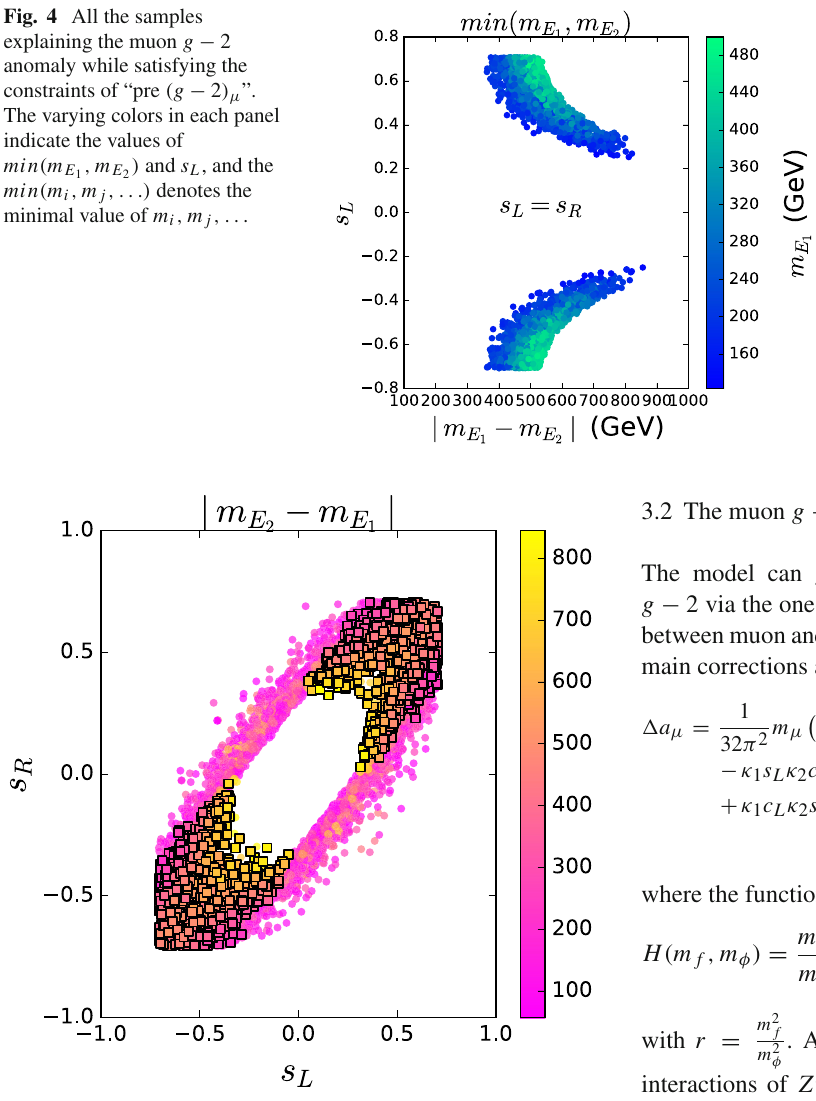
Fig. 5 All the samples explaining the muon g − 2 anomaly while sat- isfying the constraints of “pre ( g − 2 ) μ ”. The squares and circles are allowed and excluded by the diphoton signal data of 125 GeV Higgs, respectively. The varying colors indicate the values of | m E